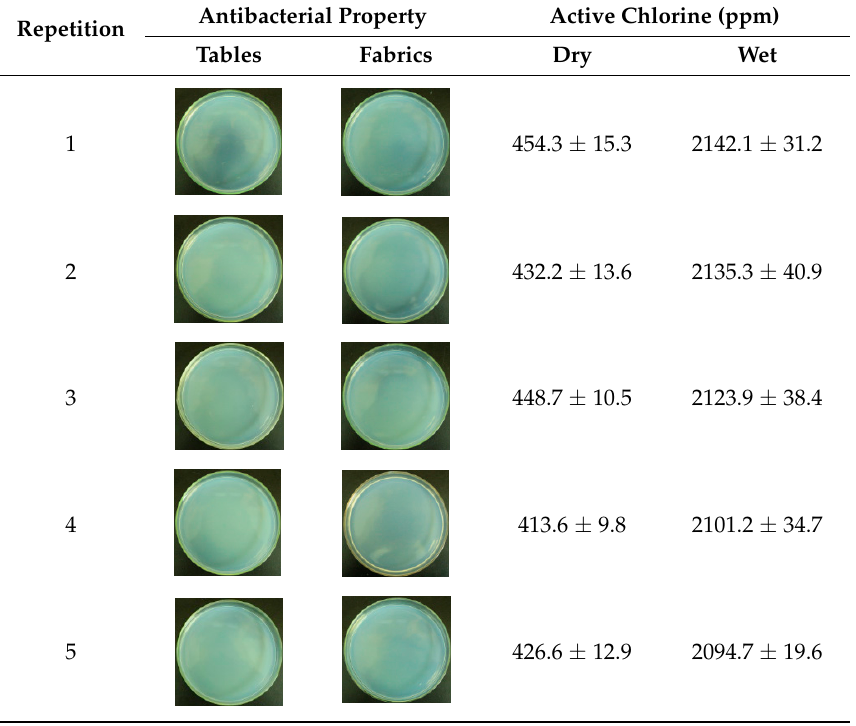
Figure 6. ( A ) FTIR-ATR spectra of the fabric after 5 recharging cycles: ( a ) pristine fabric, ( b ) after cleaning 150 tables, ( c ) difference spectrum of subtracting (a) from (b), ( B ) SEM image of the fabric after 5 recharging cycles. Table 2. The antibacterial properties and active chlorine contents after repeated chlorine recharges. Repetition Tables